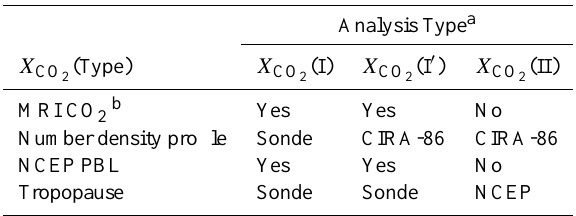
Table 1. Types of analyses of X CO and model